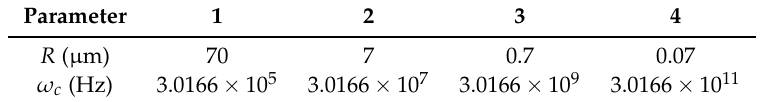
Figure 9. The frequency dependence of the amplitude and phase for SPC with different equivalent radius: ( a ) the amplitude; ( b ) the phase. Table 4. The radius of the capillary and related transition frequency used in modeling C sp in Figure